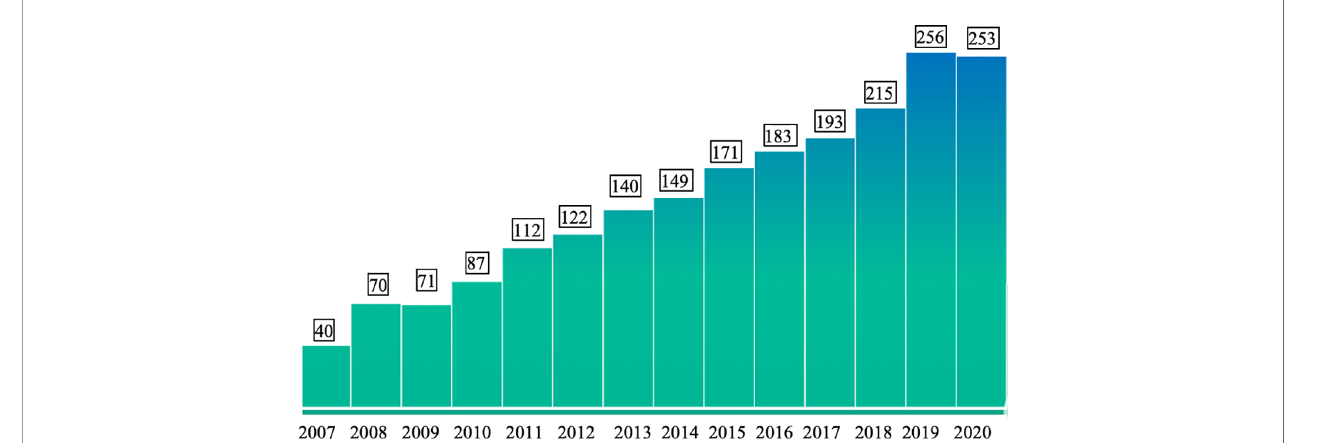
FIGURE 1 | Numbers of publications per year (y-axis) from 2007 to 2020 (x-axis) which can be retrieved from PubMed (https://pubmed.ncbi.nlm.nih.gov/) with the keywords “ Allergy ” and “ Allergen ” and “ China ”